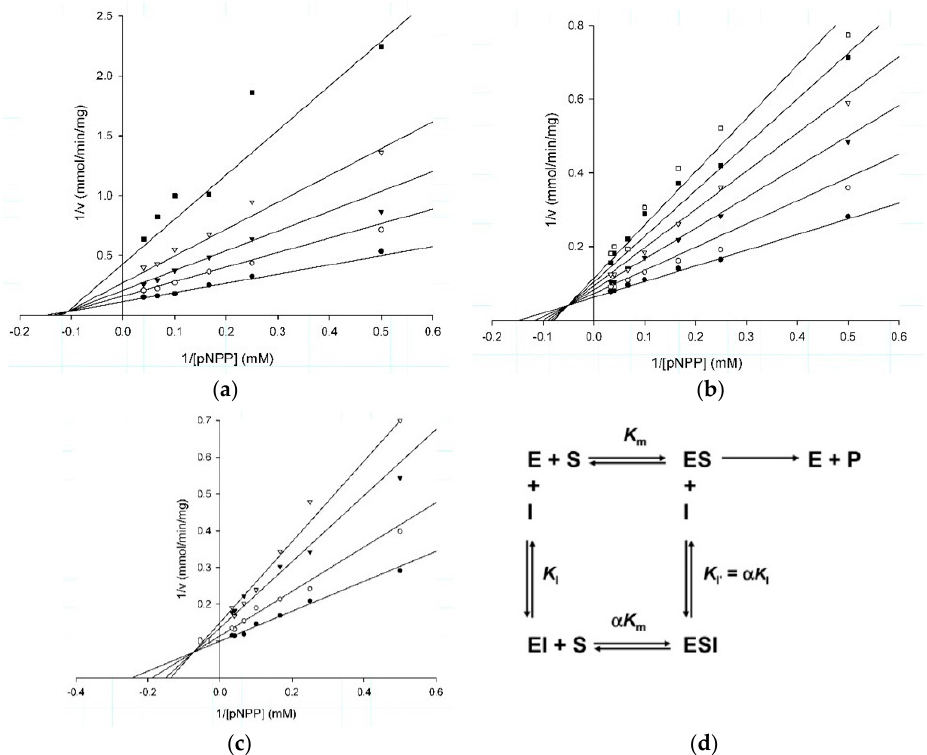
Figure 2. Lineweaver-Burk plots of ( a ) compound 1 at 0 (filled circles), 3 (open circle), 6 (filled triangle), 10 (open triangle), and 20 µM (filled squares); ( b ) compound 2 at 0 (filled circles), 2 (open circle), 4 (filled triangles), 6 (open triangles), 8 (filled squares), and 10 µM (open squares); and ( c ) compound 3 at 0 (filled circles), 20 (open circle), 50 (filled triangles), and 70 µM (open triangles); ( d ) kinetic model for mixed type inhibition. In the scheme, E corresponds to free enzyme; S is the substrate; ES is the enzyme-substrate complex; EI corresponds to the enzyme-inhibitor complex; ESI is the enzyme-substrate-inhibitor ternary complex; and P is the reaction product.